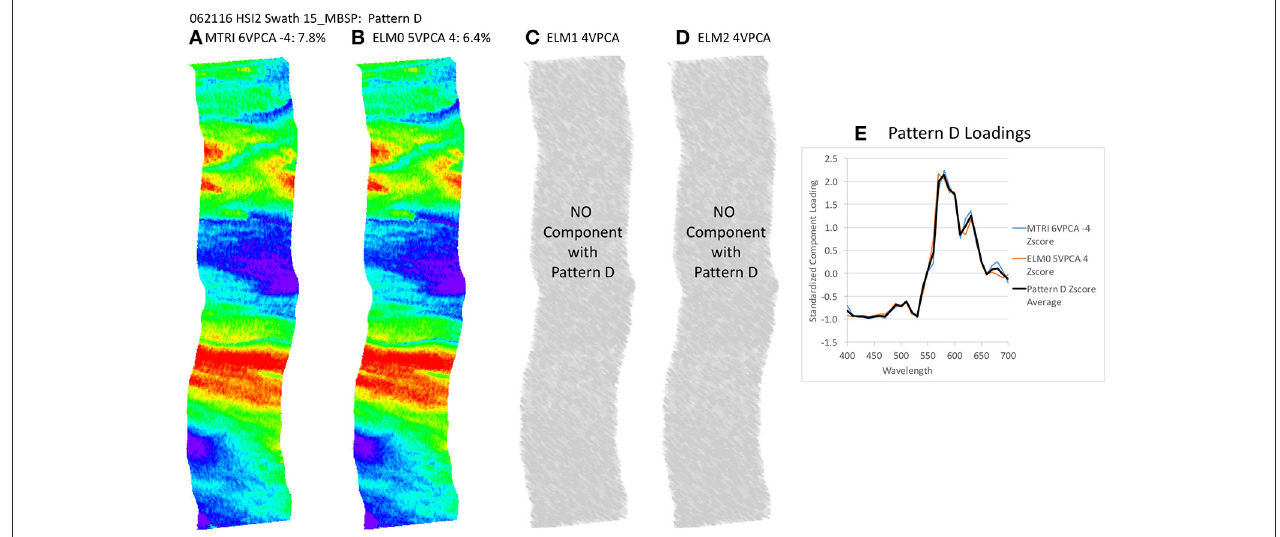
FIGURE 11 | Spatial distribution of varimax-rotated principal component analysis (VPCA) component pattern D. (A) Michigan Tech Research Institute (MTRI) correction method decomposition. (B) Empirical Line Method 0 (ELM0) correction method decomposition. (C) Empirical Line Method 1 (ELM1) correction method